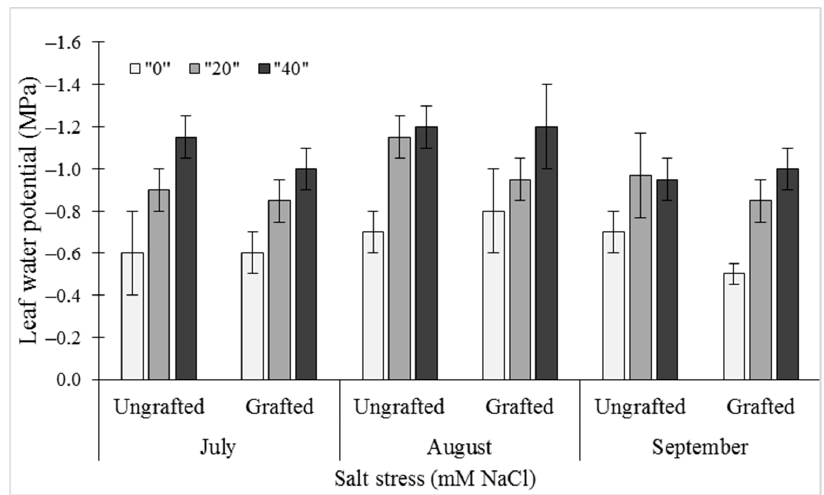
Figure 1. Effects of salt stress (0 mM, 20 mM, 40 mM NaCl) on midday leaf water potential ( ψ ) in leaves of ungrafted UG) and grafted (G) bell pepper plants, as measured in July, August, and September. Data are means ± standard deviation of three replicate samples (n = 3). Table 2. Effects of salt stress on leaf photosynthetic traits in July, August, and September for ungrafted and grafted pepper plants, and their salinity, grafting, and date interactions. Salinity Grafting Net CO 2 Assimilation Rate (P n ) Stomatal Conductance (g s ) Transpiration Rate (E) (mM NaCl) 0